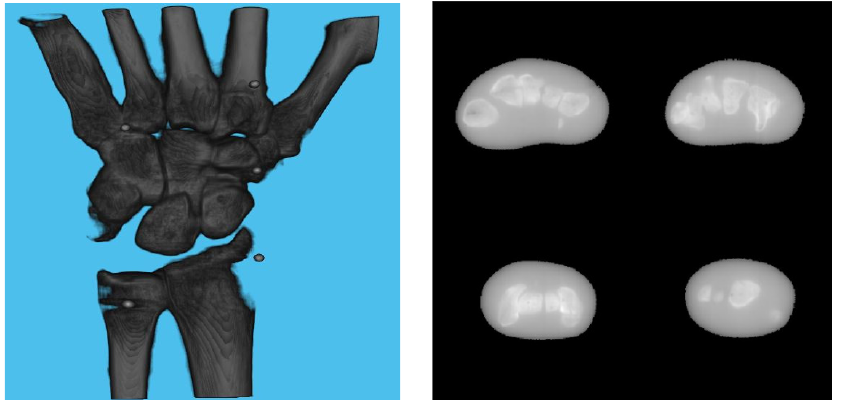
Figure 6. Volume rendering of the CT scan of wrist phantom ( left ). A projection of the volume ( right ).